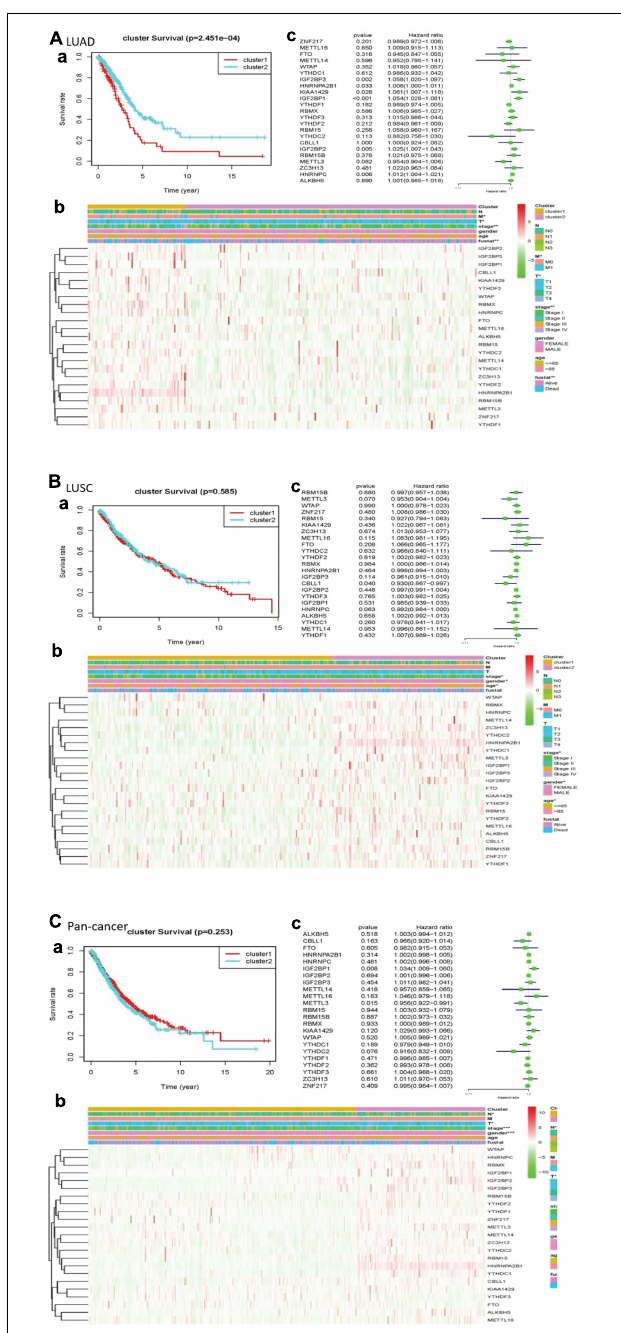
FIGURE 3 | Clinical pathological characteristics and overall survival rate of cluster 1 and cluster 2 in different lung cancers, as well as the risk signature with m 6 A RNA methylation regulators. (A) LUAD; (B) LUSC; (C) pan-cancer. (a) Survival plot. The graph plots the overall survival curves of cluster 1 and cluster 2 in different lung cancers. Red represents cluster 1, and blue represents cluster 2. (b) Heatmap. The heat map shows the expression of m 6 A RNA methylation regulator in two clusters and its clinical pathological characteristics. When P < 0.05, the result is meaningful. (c) Univariate Cox regression. The graph records the hazard ratio and 95% confidence interval calculated by univariate Cox regression. The univariate analysis is beneficial to select the meaningful genes.